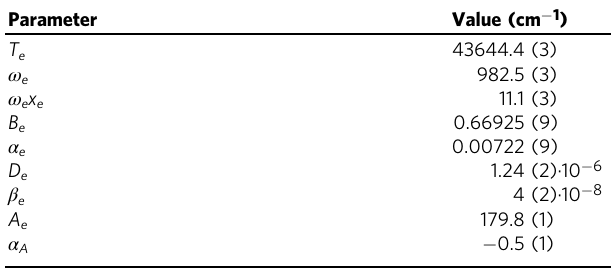
Table 1 Measured spectroscopic constants of the C 2 Π